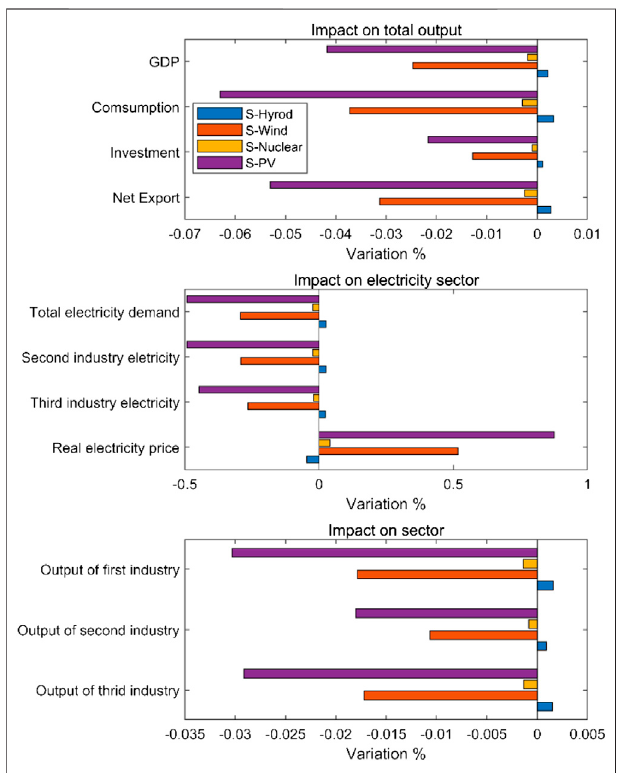
FIGURE 4 | The marginal impact of different power sources